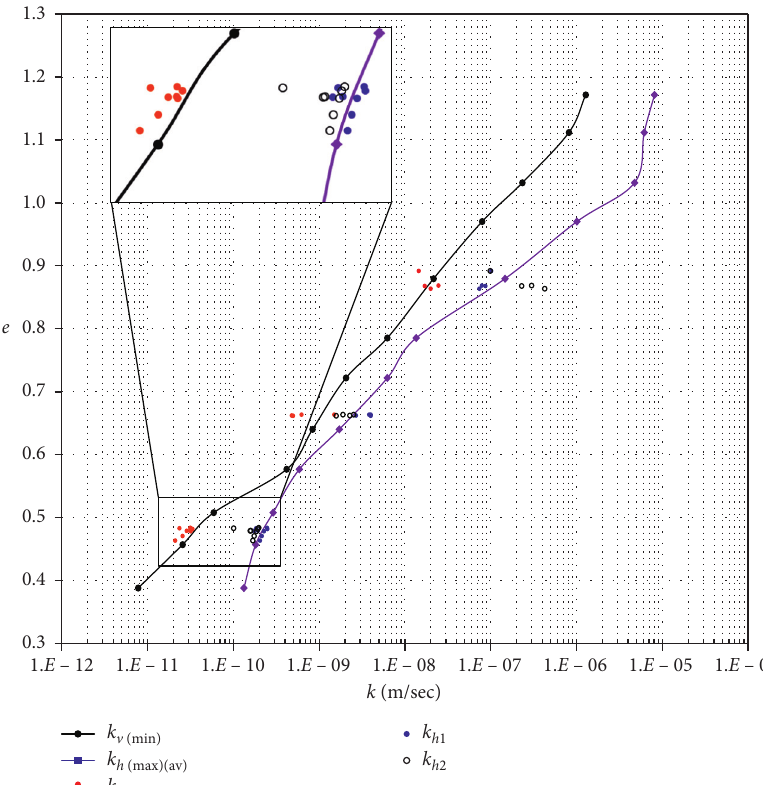
Figure 11: The plot of the k v , k h 1 , and k h 2 values measured during simple shear deformation on the k h (max) and